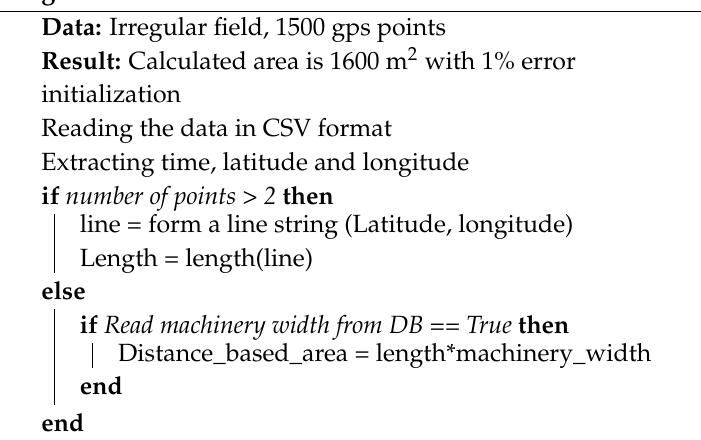
Algorithm 3: Distance Based Mechanism Data: Irregular field, 1500 gps